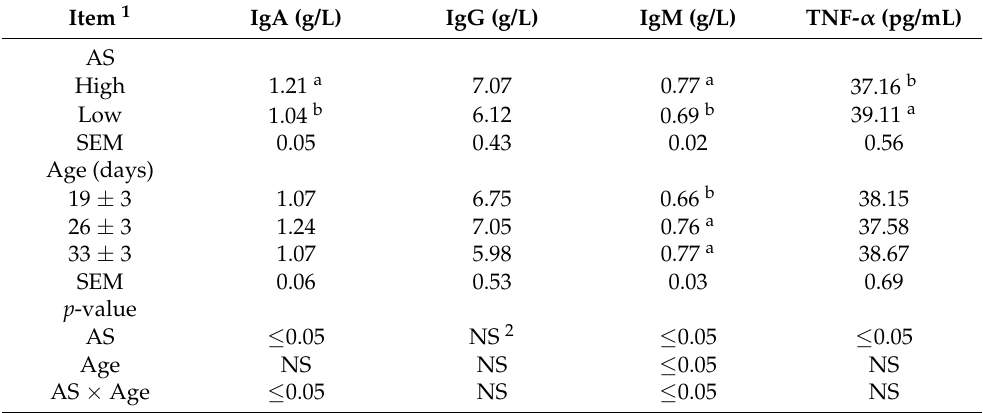
Table 9. Immunity parameters of calves in D19-HA and